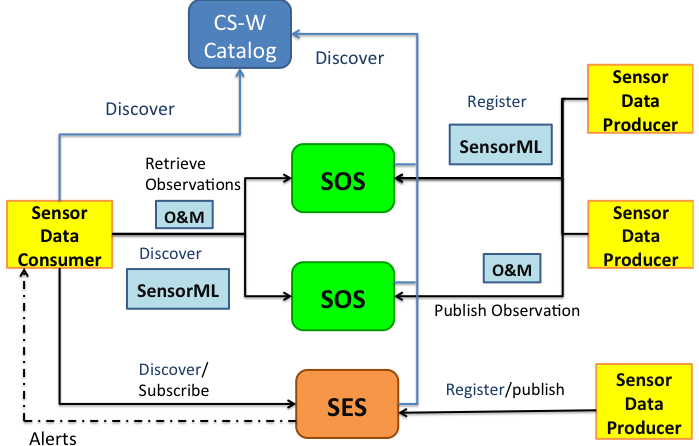
Figure 3. Sensor Web Infrastructure example with services defined by the